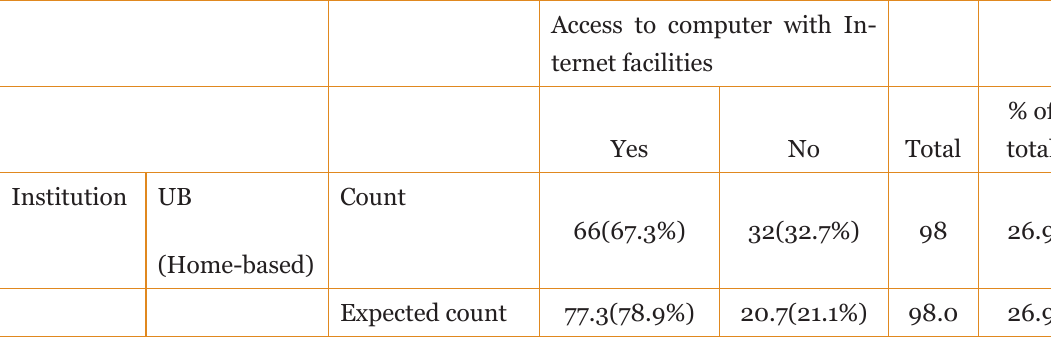
Access to computer with In- ternet